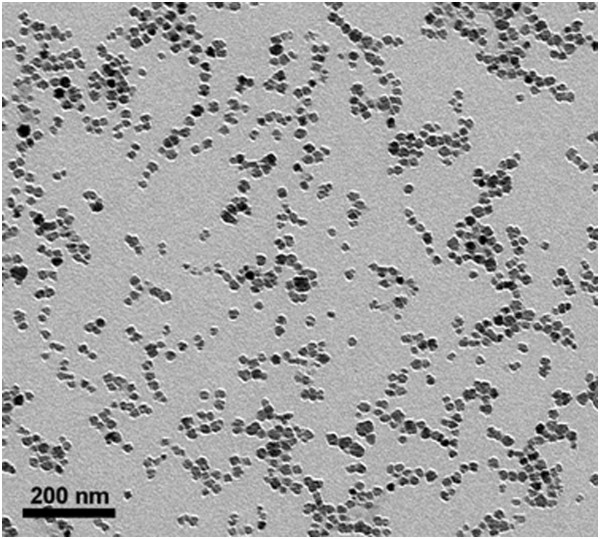
TEM image of the fibrin γ377-395 peptide-conjugated γ-Fe2O3 nanoparticles. The transmission electron microscope (TEM) image of the fibrin γ377-395 peptide-conjugated γ-Fe2O3 nanoparticles demonstrates that these nanoparticles are stable against agglomeration and possess a diameter of 21 ± 3.5 nm.